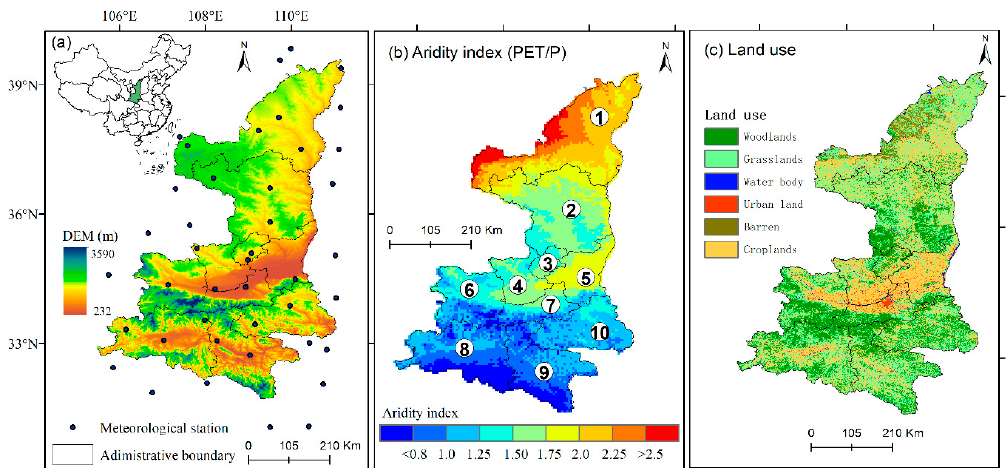
Figure 1. The location and terrain of the study area ( a ) and the spatial patterns of aridity index ( b ) and land use ( c ) across the study area. The study area includes ten prefecture-level cities (see Figure 1b), namely Yulin ( ① ), Yan’an ( ② ), Tongchuan ( ③ ), Xianyang ( ④ ), Weinan ( ⑤ ), Baoji ( ⑥ ), Xi’an ( ⑦ ), Hanzhong ( ⑧ ), Ankang ( ⑨ ), and Shanluo ( ⑩ ), respectively.